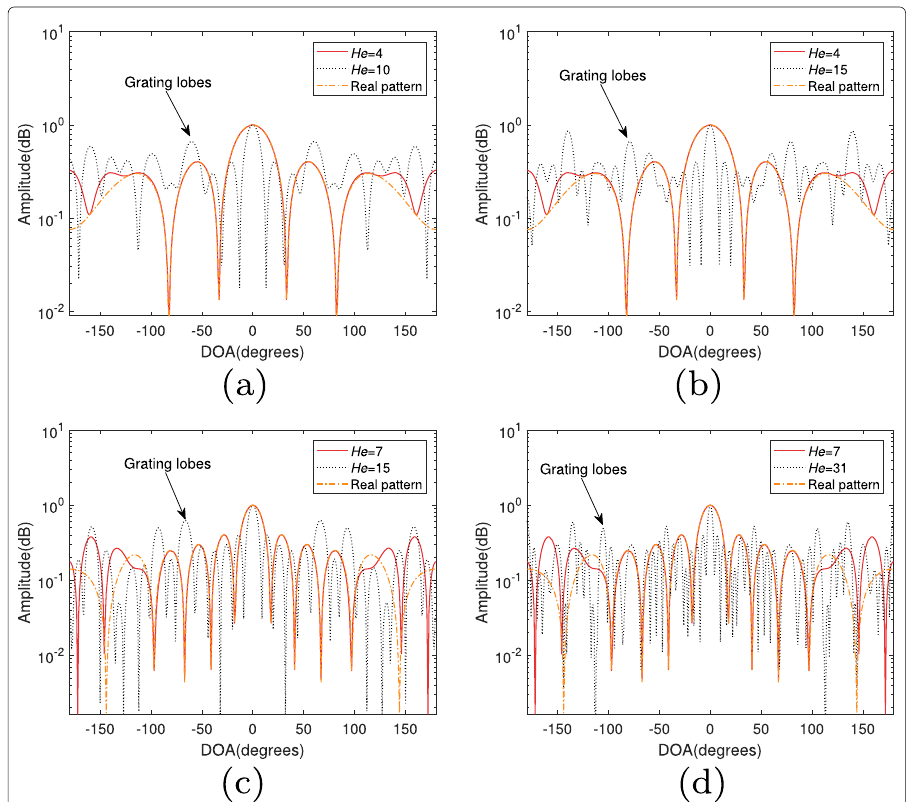
Fig. 1 Comparison of pattern amplitudes for the M -sensor UCA. ( a ) M =9, H e is 4, 10, correspondingly r = 0.6 λ , 1.5 λ . ( b ) M =9, H e is 4, 15, correspondingly r = 0.4 λ , 1.5 λ . ( c ) M =16, H e is 7, 15, correspondingly r = 0.8 λ , 0.4 λ . ( d ) M =16, H e is 7, 31, correspondingly r = 0.8 λ , 0.2